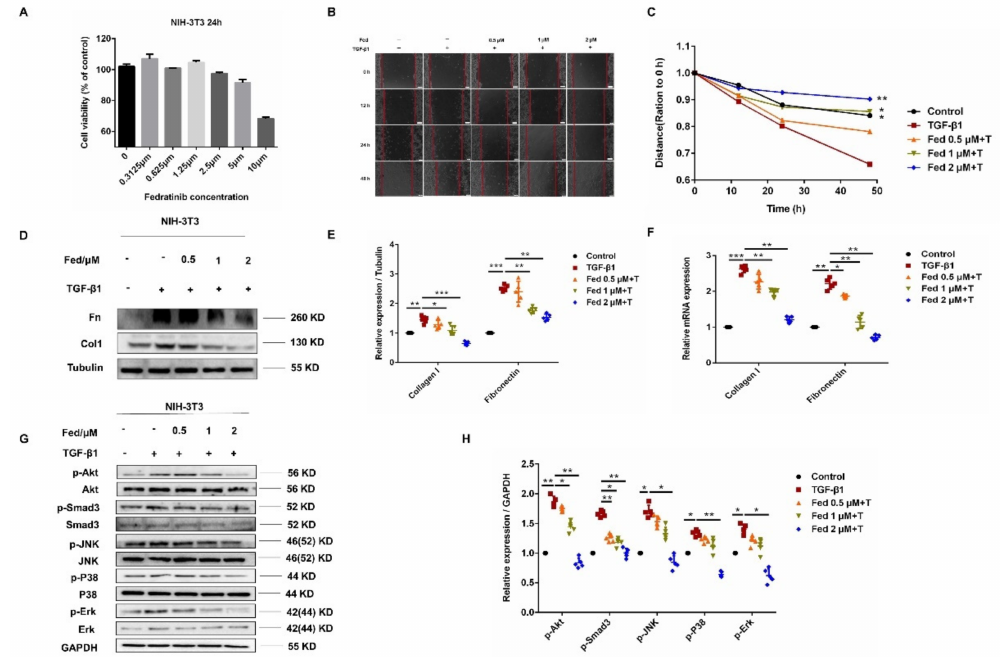
Figure 4. Fedratinib suppresses TGF- β 1-induced myofibroblast proliferation, migration and activation. ( A ) MTT assays of NIH-3T3 cells. Cells were exposed to the indicated doses of Fed (0 to 10 µ M) for 24 h, IC 50 = 11 µ M. ( B , C ) A wound healing assay was used to assess the effect of Fed on fibroblast migration. The wound closure was photographed at 0, 12, 24 and 48 h post-scratching. Experiments were performed in triplicate. ( D , E ) NIH-3T3 cells were treated with TGF- β 1 (5 ng/mL) and Fed (0.5, 1 and 2 µ M) for 24 h. The protein levels of Col1 and Fn were analyzed by Western blot. ( F ) The mRNA levels of Col1 and Fn were analyzed by real-time PCR. ( G , H ) The phosphorylation levels of Smad3, P38, JNK, Erk and Akt were analyzed by Western blot in NIH-3T3. β -tubulin and GAPDH were used as loading control in grayscale analysis. Data are presented as the means ± SD ( n = 5). Comparisons between groups were achieved using one-way analysis of variance (ANOVA). * p < 0.05, ** p < 0.01, *** p <